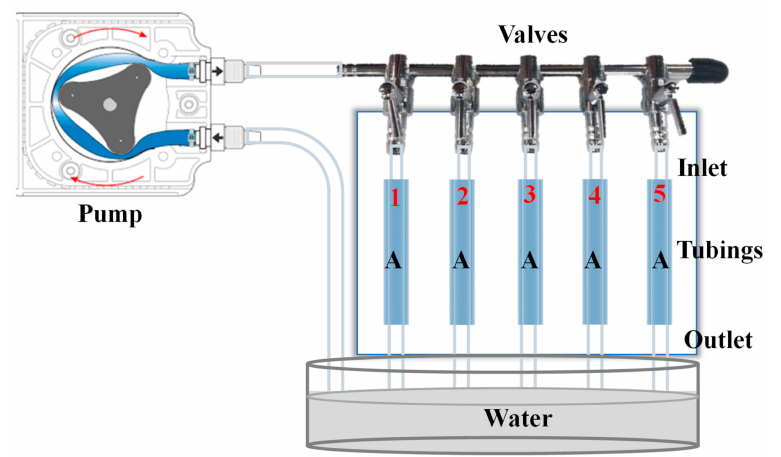
Figure 6. The five tubes were connected to the pumping system with pieces of papers marked with the letter “A” placed beneath. This experiment clearly illustrates the di ff erences in transparency among the five